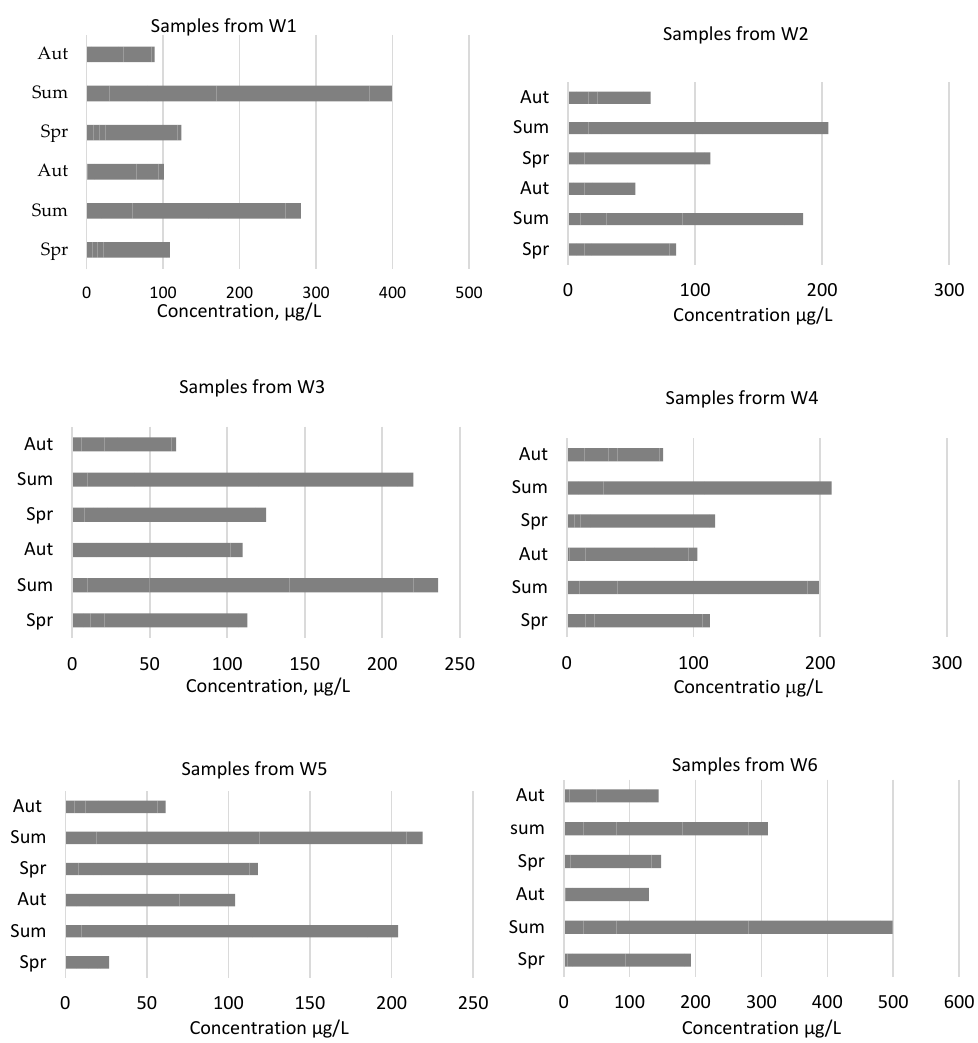
Figure 3. Total amount of contaminants in the river and ditch water during research period (Aut— autumn season, Sum—summer season, Spr—spring season).